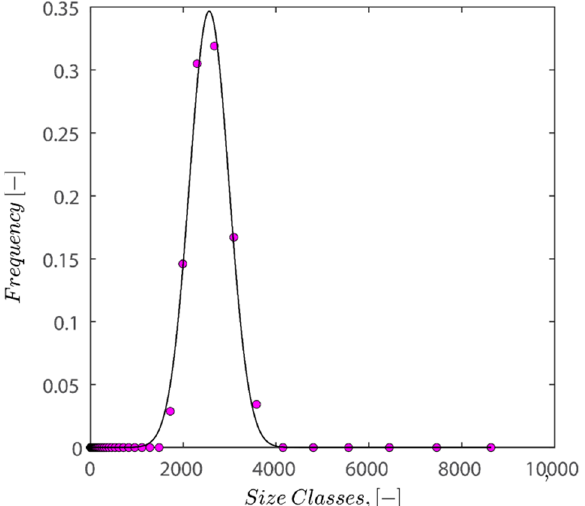
Figure 13. Depiction of the size distribution of kaolin particles under the conditions of pH 7, 25 °C, and 0.1 wt% of kaolin concentration alongside the fitted Gaussian fit distribution. and 0.1 wt% of kaolin concentration alongside the fitted Gaussian fit